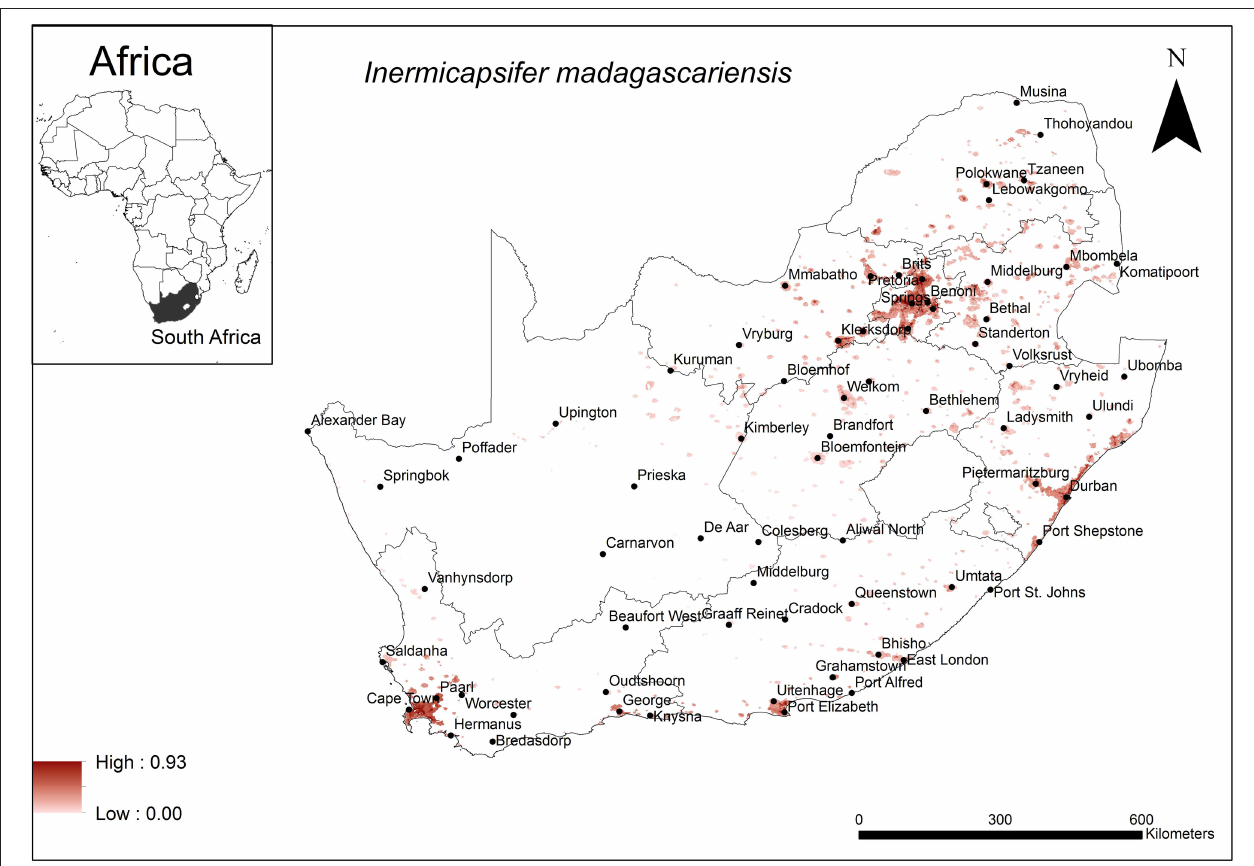
FIGURE 6 | A map showing predicted occurrence of I. madagascariensis in South Africa based on environmental suitability (shaded areas). White (non-shaded) areas represent areas where data were